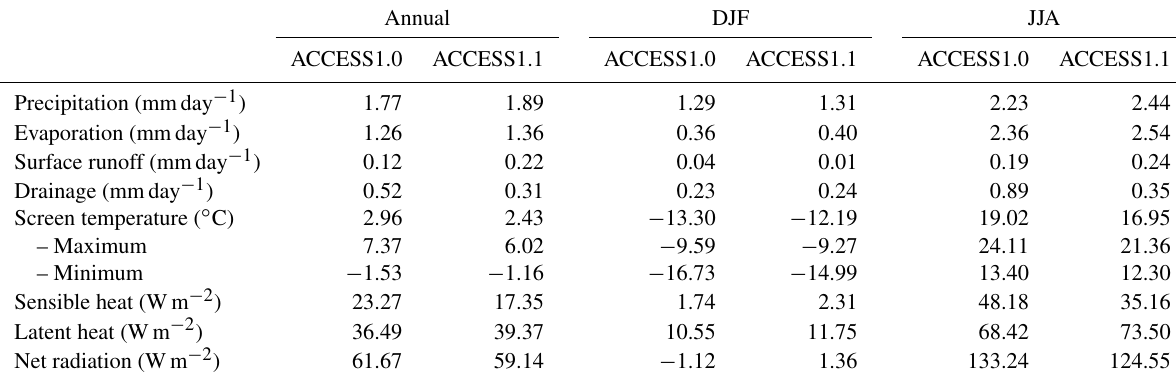
Table 3. Water and energy budget components, averaged over all land surfaces above 30 ◦ N excluding Greenland – annual, DJF and